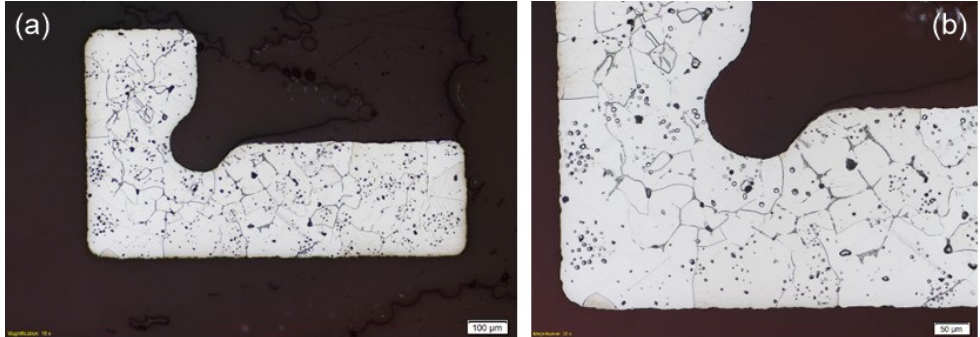
Figure 6. Cross-cut of an L-angle sample showing the microstructure as obtained after sintering: ( a ) in full size and ( b ) enlarged.